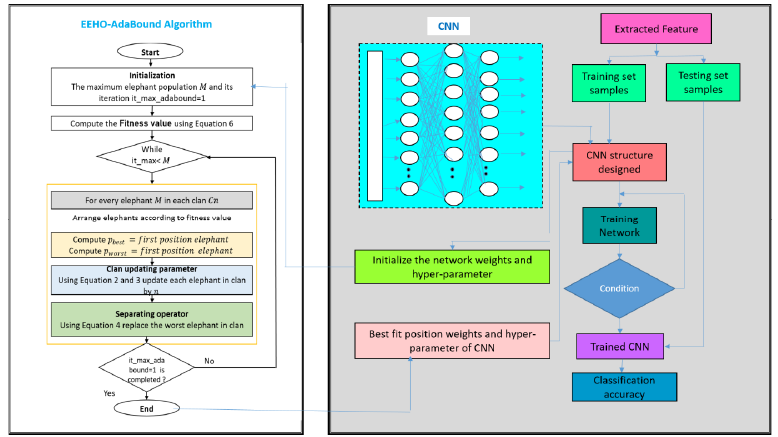
Figure 3. The CNN–EEHO–AdaBound flowchart for HSI classification.